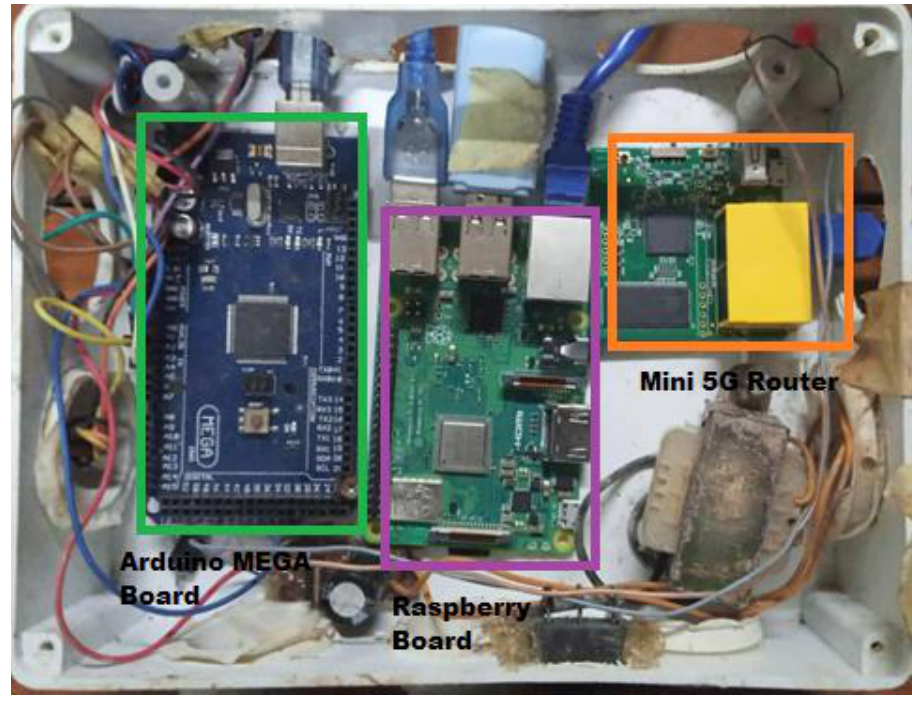
Figure 5 . S.A.D. Management and Control